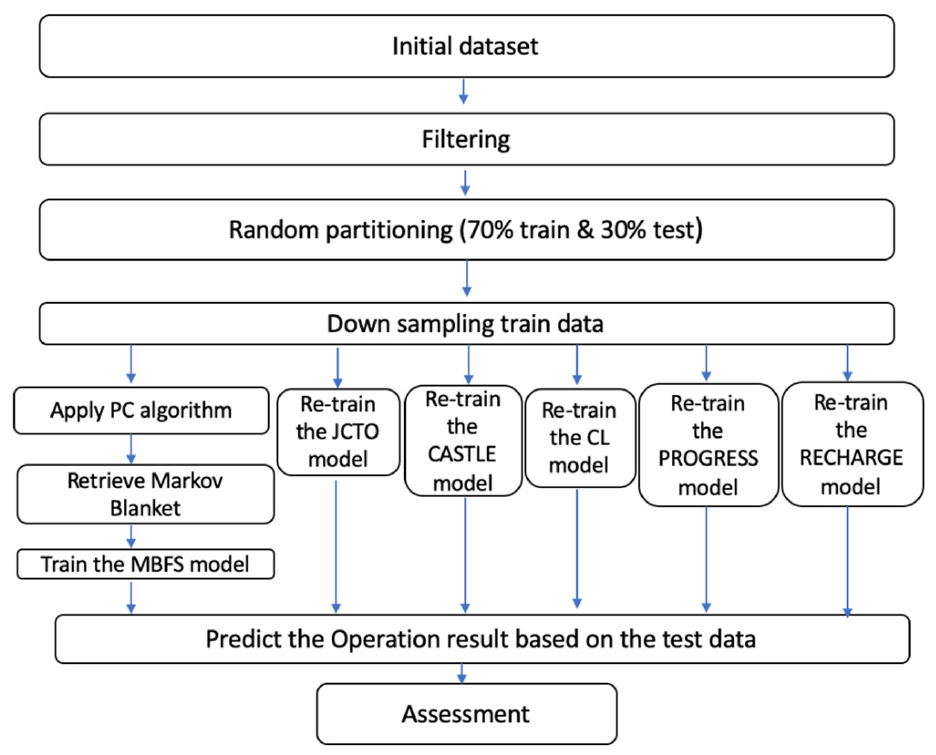
Figure 1. Flowchart depicting the methodological procedure of the analysis.